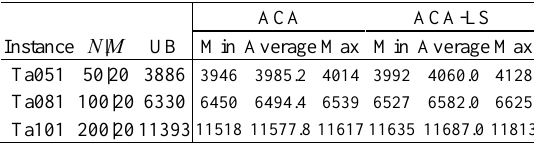
Table 1. Computational results with and without local